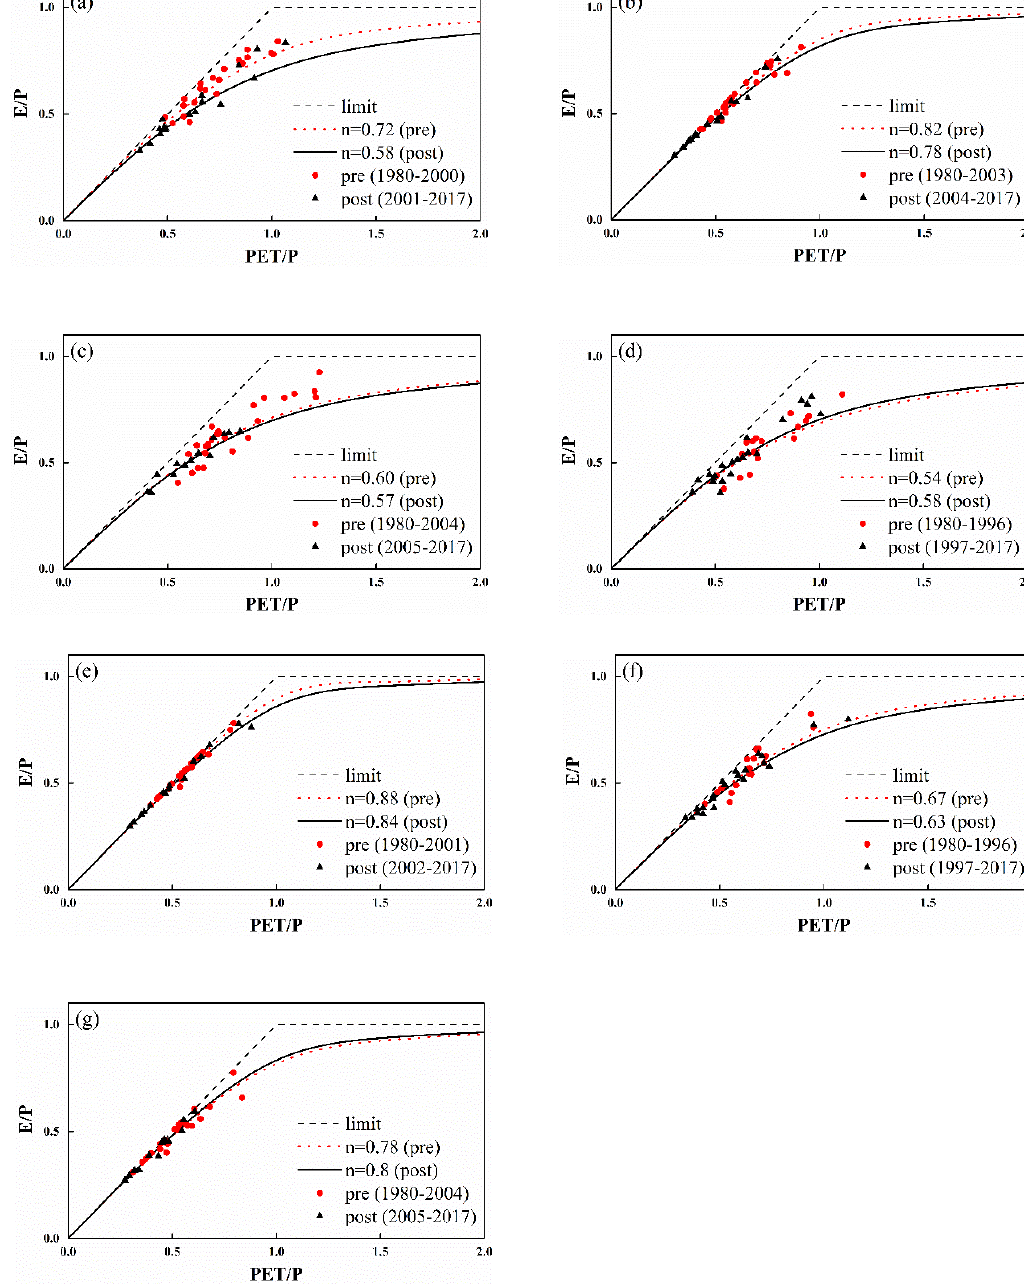
Figure 6. Correlation between the evaporation ratio versus the aridity index and the fitted Budyko-type curves with the Wang-Tang equation between pre- and post-period in each river basin, ( a ) Bazhang River Basin, ( b ) Zengwen River Basin, ( c ) Yanshui River Basin, ( d ) Erren River Basin, ( e ) Gaoping River Basin, ( f ) Donggang River Basin, ( g ) Linbain River Basin.